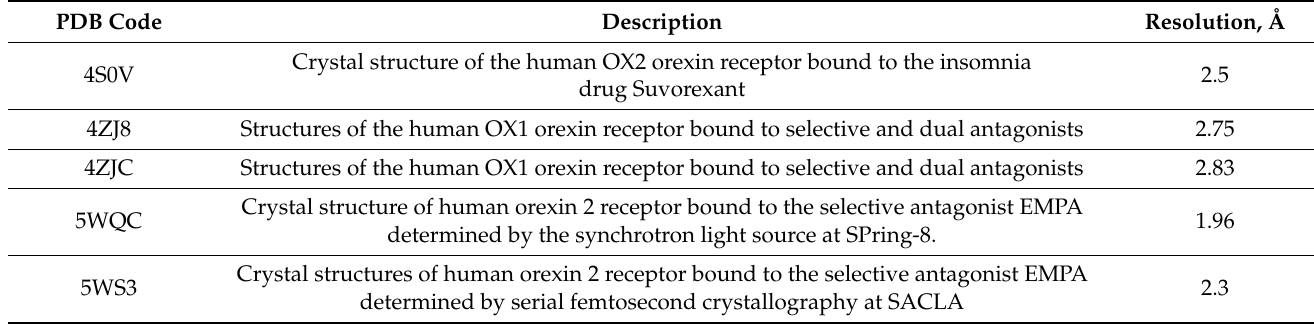
Table A3. A list of all orexin receptor structures used in Figure 5. Included are the PDB code, description, and resolution in